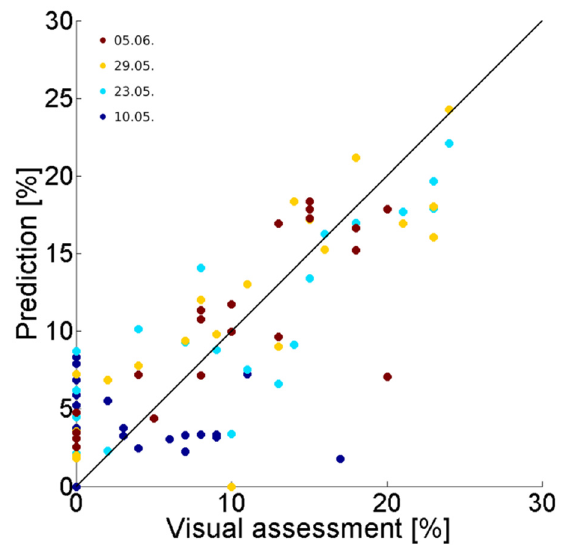
Figure 7. Prediction results of a YR infestation obtained by applying a leave-one-out procedure to the support vector regression (SVR) on the UAV scale. Each point represents a plot observation, and its color, the observation date (DD-MM). Table 2. Performance values for different SVM and SVR models predicting the treatments of the wheat field experiment based on UAV observations.